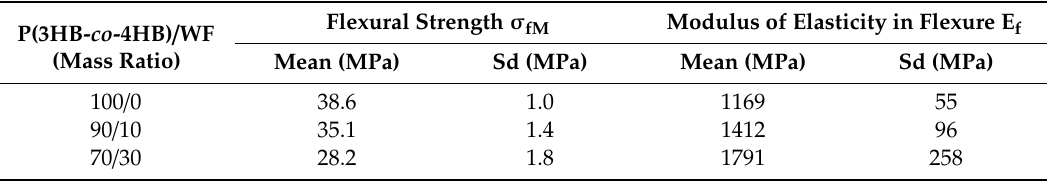
Table 3. Result of flexural strength and modulus of elasticity in flexure determined under three-point bending tests of P(3HB-co-4HB) composites with wood